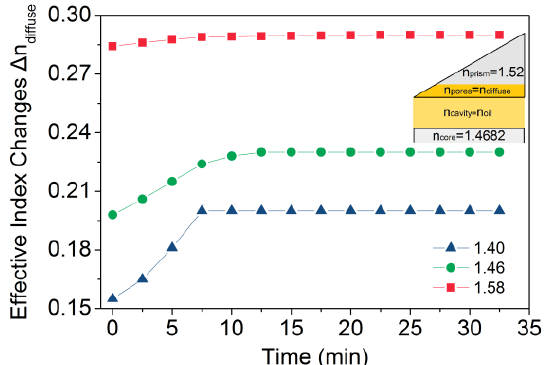
Figure 6. Effective index changes versus immersion time in the oily sample, for three oils with the lowest refractive indices from the series AA, A1 and A2. The refractive indices that were used for the applied three-layer FP theoretical model are presented in the inset schematic representation (see text). Assuming that by the immersion of the sensing head in the refractive index oil, the refractive index of the open cavity is equal to that of the used oil n cavity = n oil , the average refractive index n diffuse